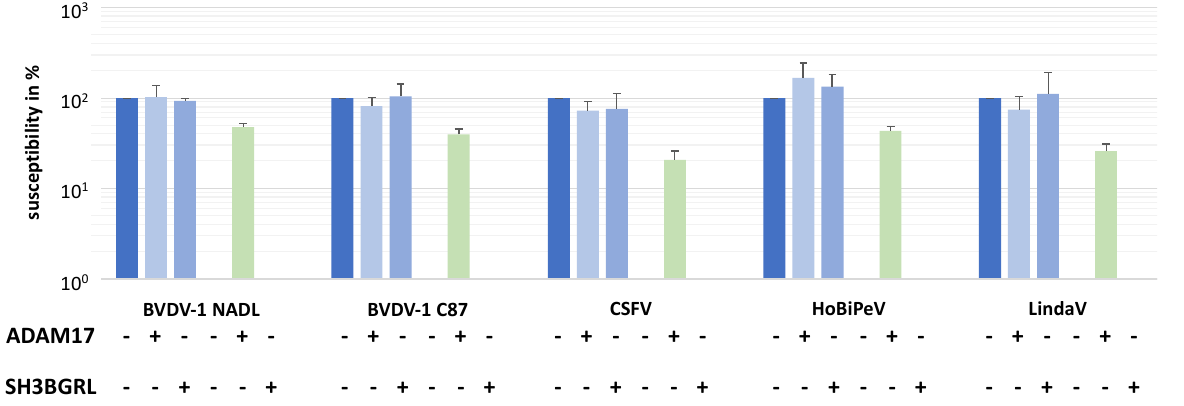
Figure 3. Transcomplementation of bovine ADAM17 renders CRIB-1 cells susceptible to pestiviruses. Susceptibility of MDBK cells (blue) or CRIB-1 (green) cells with (+) or without ( − ) transcomplementation of ADAM17 or SH3BGRL to different pestiviruses in % of the susceptibility of MDBK cells. Shown are mean and standard deviation of four independent experiments.